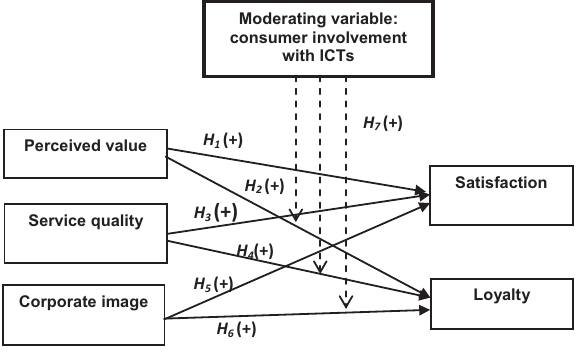
Figure 1. Conceptual proposed model for the role of consumer involvement